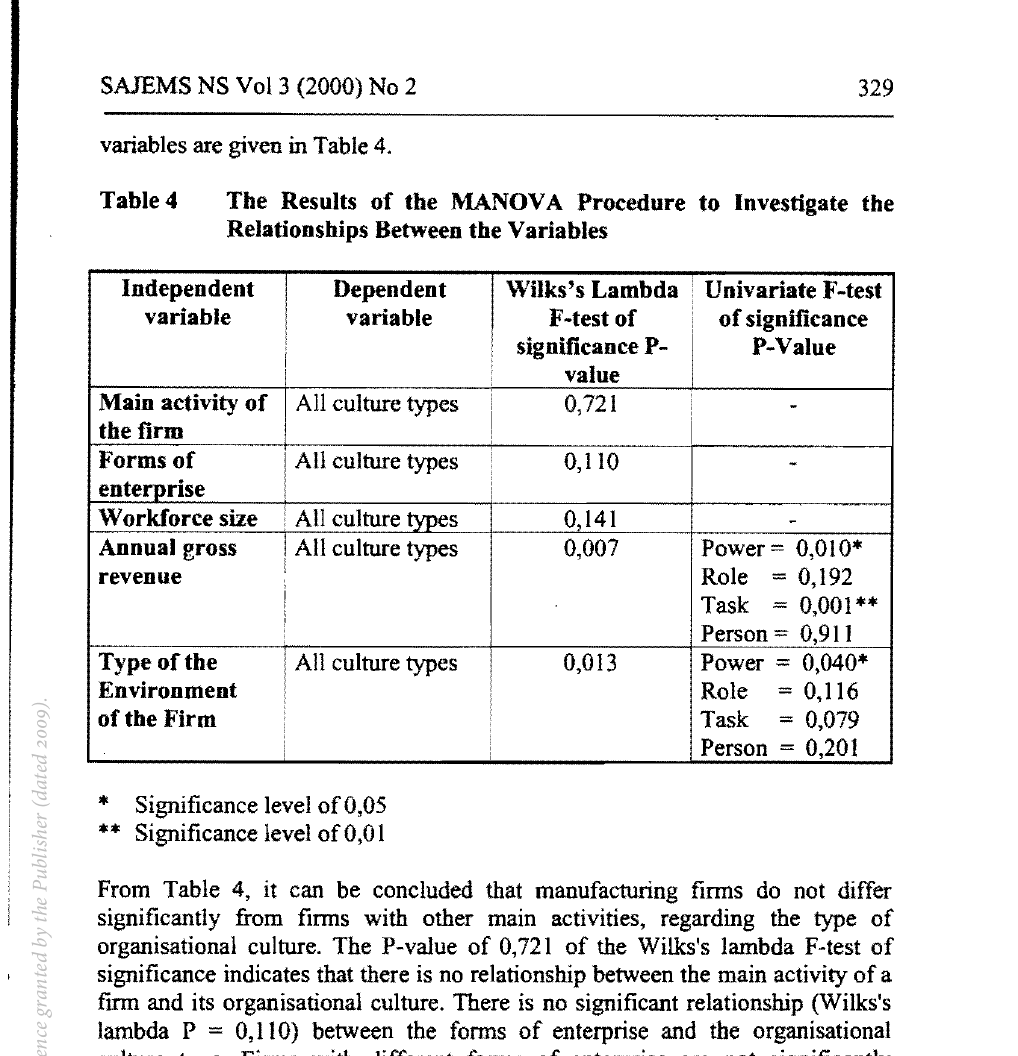
The Results of tbe MANDV A Procedure to Investigate